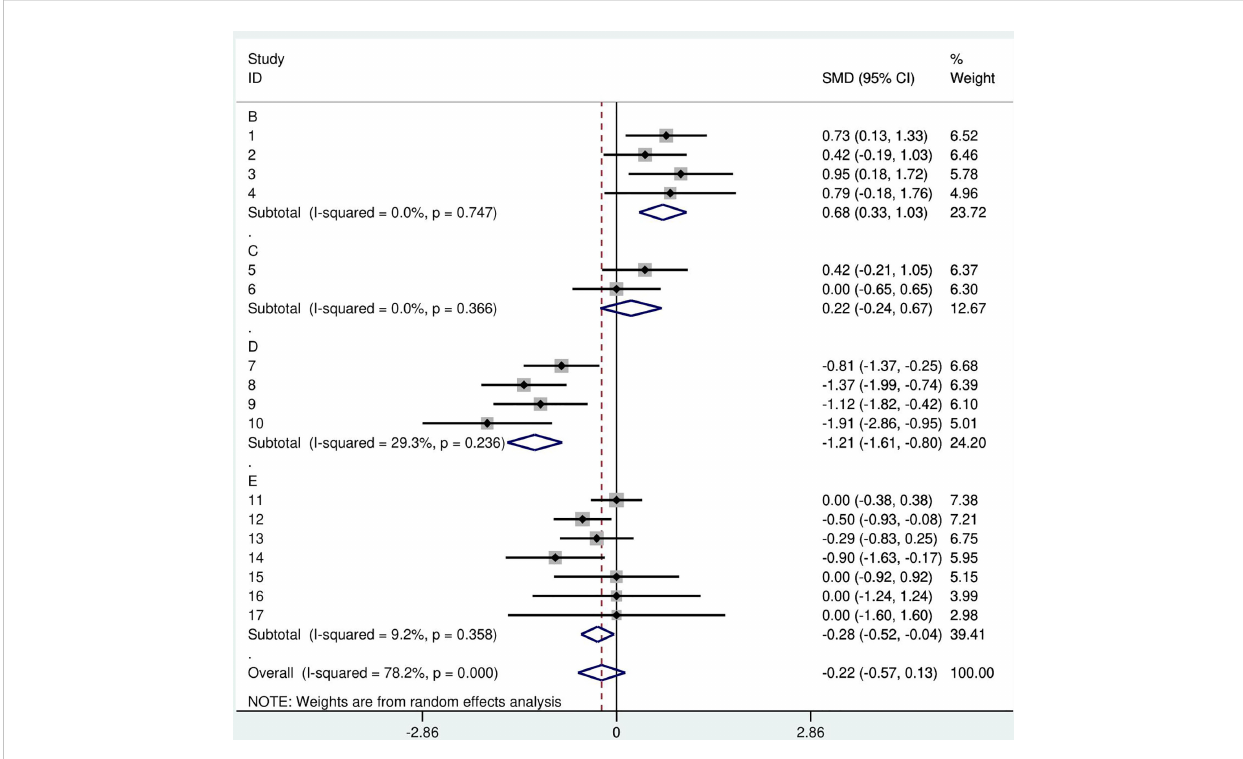
FIGURE 3 A forest plot of the GH therapy mini meta-analysis by study. Random effects meta-analysis of height SDS was performed in comparison to the reference group. Squares- point represent the result of each study, each year of GH treatment, or follow-up. A- Castells S. 1996. B- Annere ́ n G.1993. C- Torrado C. 1991. D- Meguri K 2013. E- weighted arithmetic mean of GH treated groups, F- Annere ́ n G. 1993 control